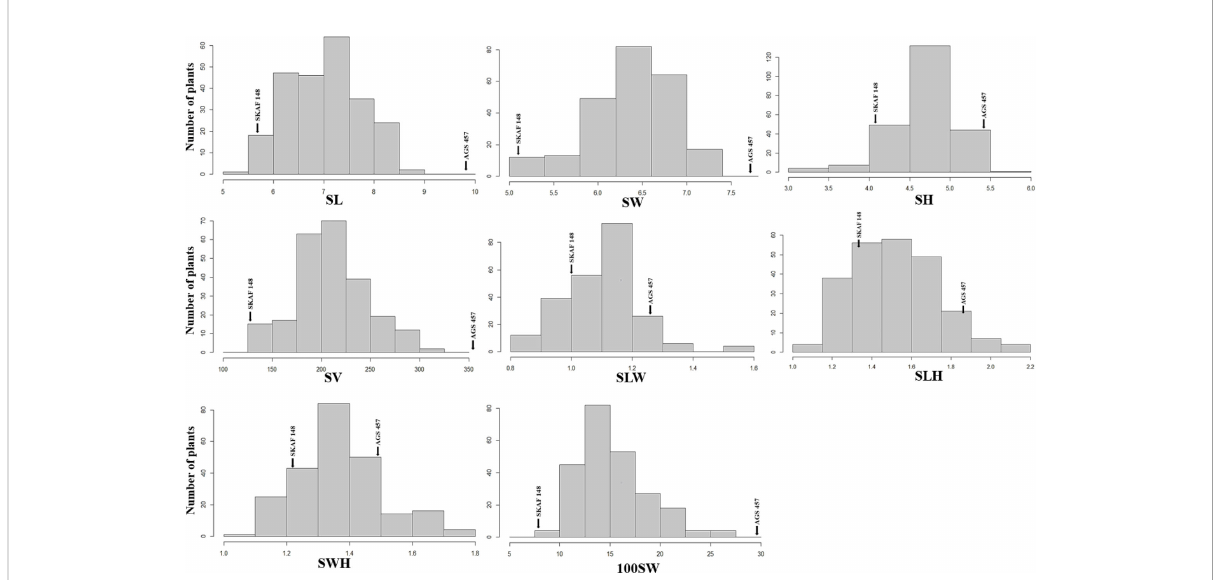
FIGURE 3 Frequency distributions of seed-related traits [SL, Seed Length (mm); SW, Seed Width (mm); SH, Seed Height (mm); SV, Seed Volume (mm 3 ); SLW, Seed Length to Width ratio; SLH, Seed length to Height ratio; SWH, Seed Width to Height ratio and 100SW, 100 seed weight (g)] in the F 2:3 population derived from the cross of AGS 457 X SKAF 148. Parental means are denoted with arrows.